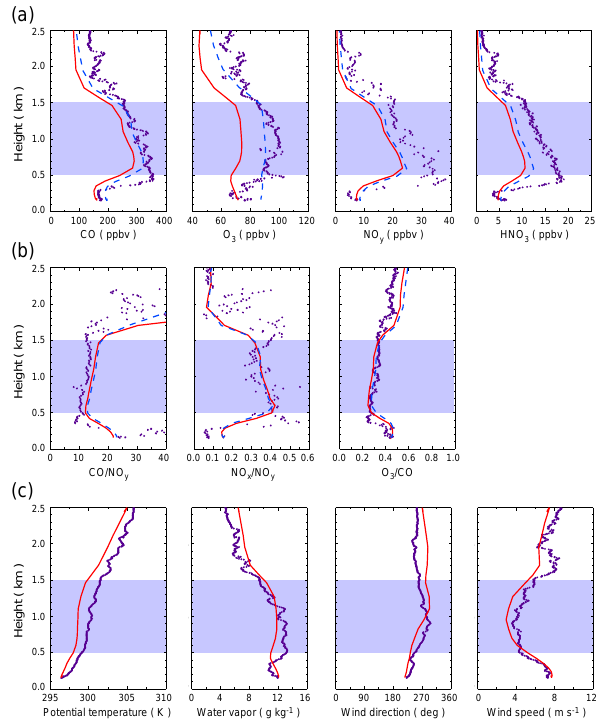
Fig. 6. Observed (dots purple line) and simulated (solid red and dashed blue lines) vertical distributions of (a) chemical species (CO, O 3 , NO y , and HNO 3 ) , (b) ratios of chemical species (CO/NO y , NO x /NO y , and O 3 /CO), and (c) meteorological fields (potential temperature, water vapor mixing ratio, and wind speed and direc- tion) in the NYC urban plume intercepted in the ascending track of the NOAA WP-3D aircraft around 18:45 UTC on 20 July. A strong NYC urban plume layer from 0.5km to 1.5km is shaded. Dashed lines in (a) and (b) show results from the simulation with chemical initial and boundary conditions including North American anthro- pogenic and biogenic emissions